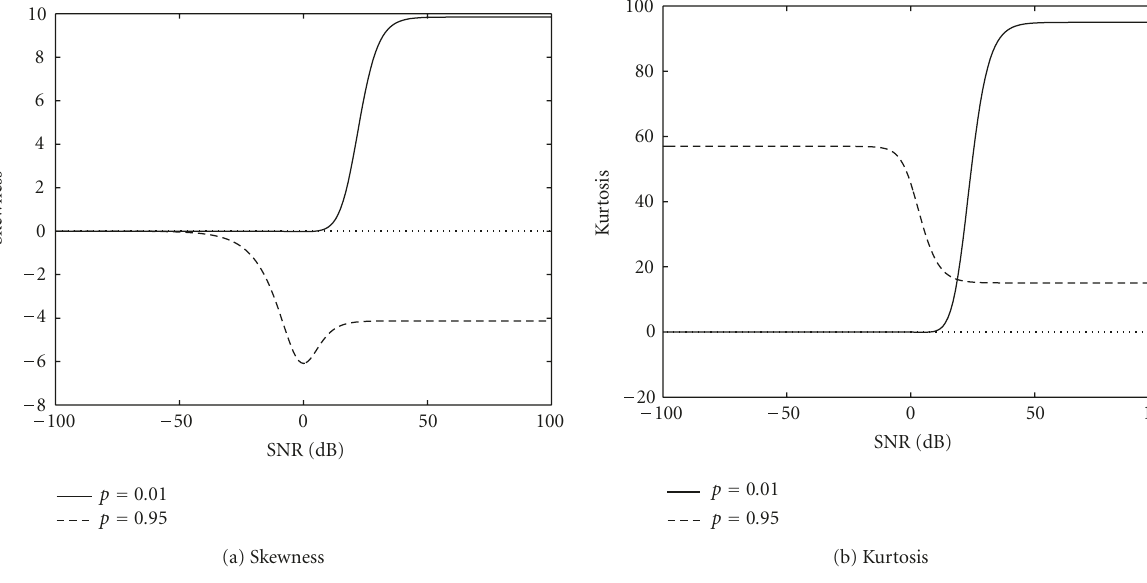
Figure 3: HOS in function of the SNR for low p (solid line) or high p (dashed